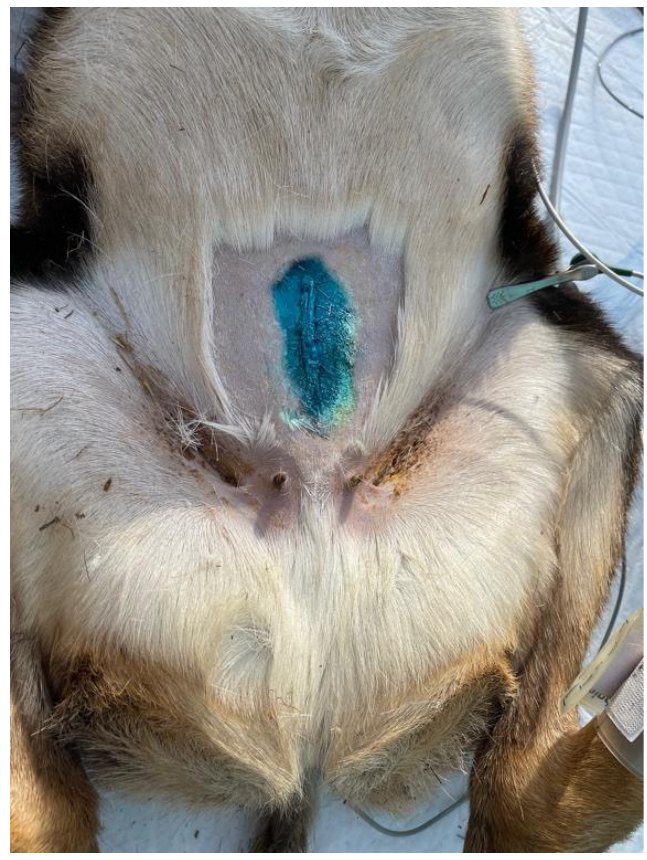
Figure 4. Area where the incision for linea alba ovariectomy was made.